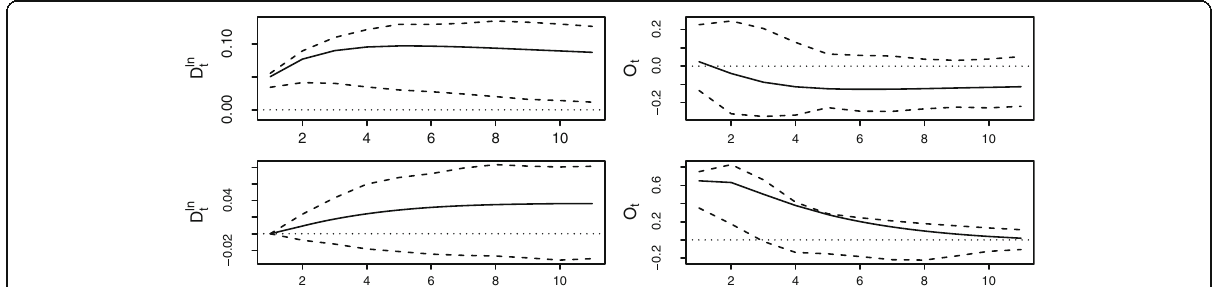
Fig. 5 Orthogonal impulse response functions with 95% bootstrap CI for recession phases. Top: from D ln and O